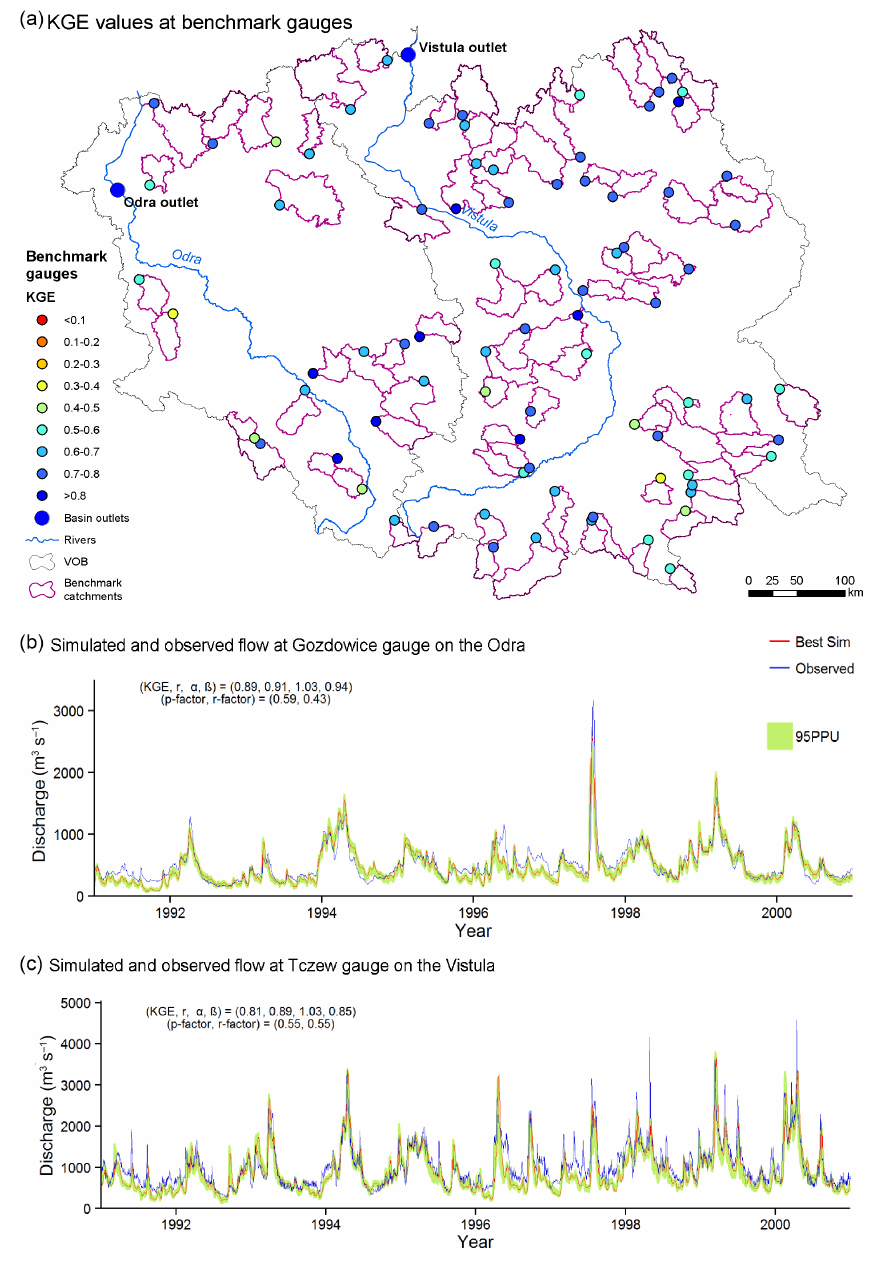
Figure 2. Calibration results: KGE values at benchmark gauges (a) , simulated and observed flows at Gozdowice gauge on the Odra (b) and at Tczew gauge on the Vistula (c) (modified after Piniewski et al.,